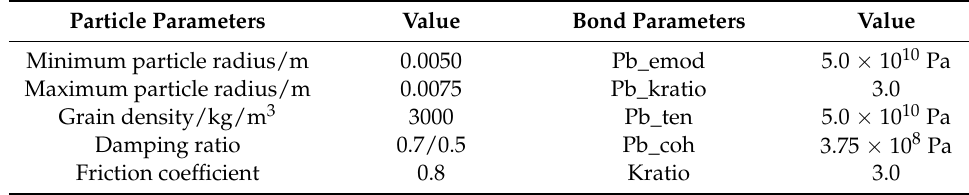
Table 4. Table of mesoscopic parameters of ore body.